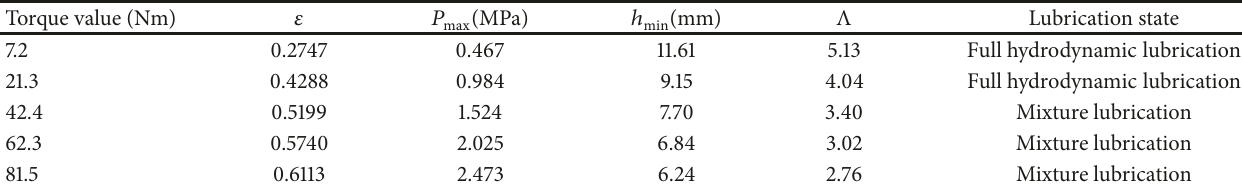
Table 5: Influence of different constant torque on main parameters of sliding bearing II.